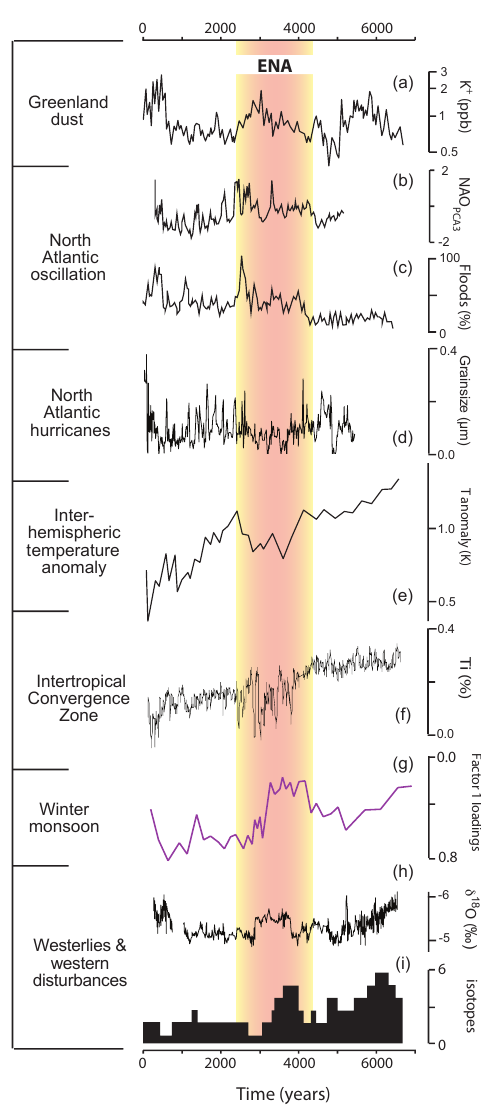
Figure 5. Northern Hemisphere hydroclimatic conditions since the middle Holocene. The period corresponding to the early neoglacial anomalies (ENA) interval is shaded in red hues. From high to low (panels labeled a through i): (a) Greenland dust from non-sea-salt K + showing the strength of the Siberian Anticyclone (O’Brien et al., 1995); (b) NAO proxy reconstruction (Olsen et al., 2012) and (c) negative NAO-indicative floods in the southern Alps (Wirth et al., 2013); (d) grainsize-based hurricane reconstruction in the North Atlantic (van Hengstum et al., 2016); (e) interhemispheric temper- ature anomaly (Marcott et al., 2013); (f) ITCZ reconstruction at the Cariaco Basin (Haug et al., 2011); (g) winter monsoon ancient DNA-based reconstruction for the northeastern Arabian Sea (this study – in purple); (h) speleothem δ 18 O-based precipitation recon- struction for northern Levant (Cheng et al., 2015); and (i) stacked lake isotope records as a proxy precipitation-evaporation regimes over the Middle East and Iran (Roberts et al.,